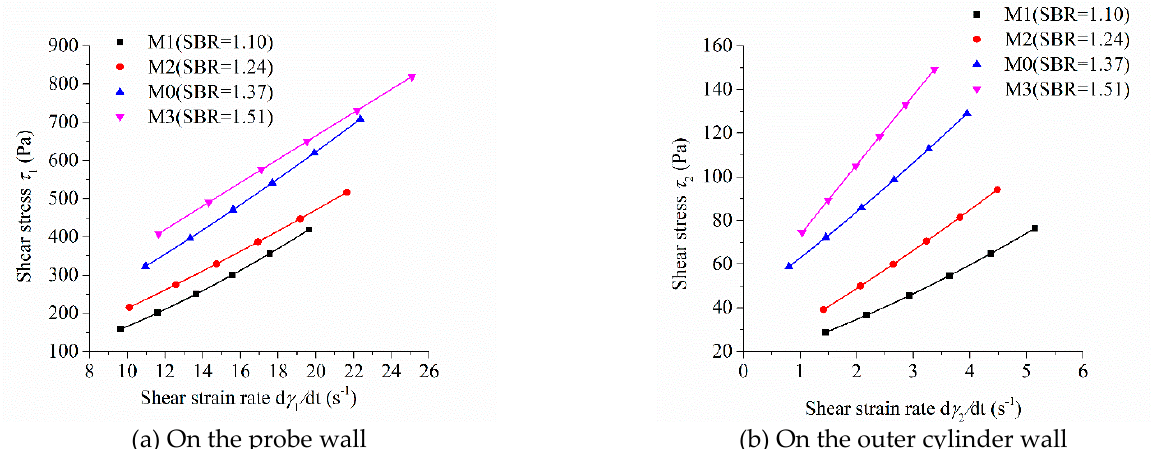
Figure 5. Relationship between shear stress and shear strain rate of mortars with different sand-binder ratios.